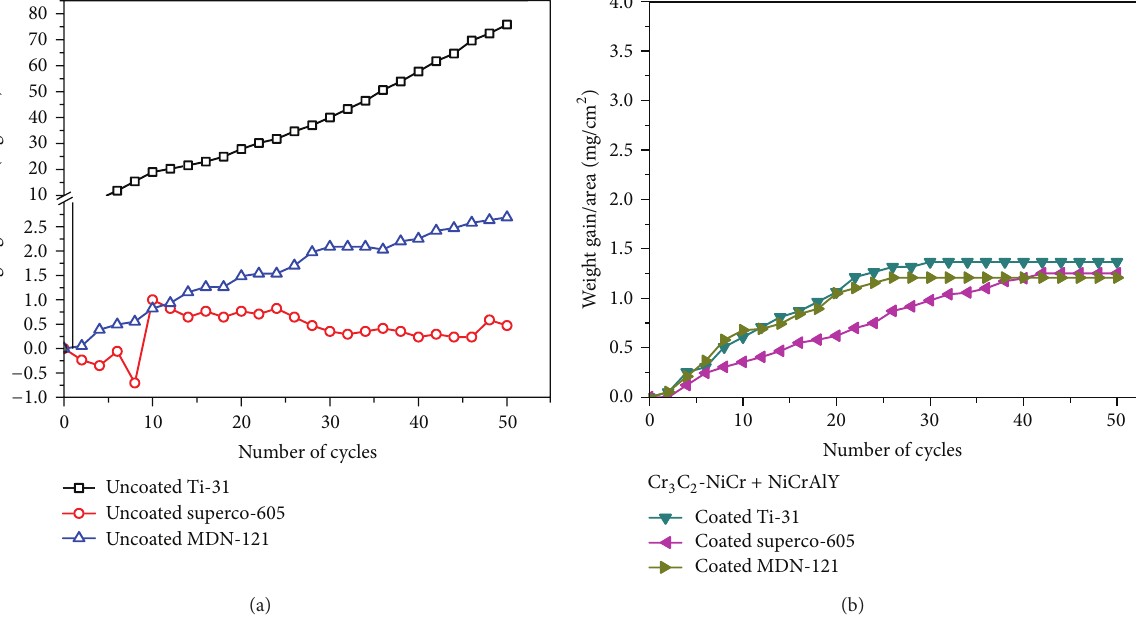
Figure 7: Plots of weight gain per unit area as a function of number of hot corrosion cycles. (a) Uncoated samples, (b) 25% (Cr 3 C 2 -25(Ni20Cr)) + NiCrAlY coated